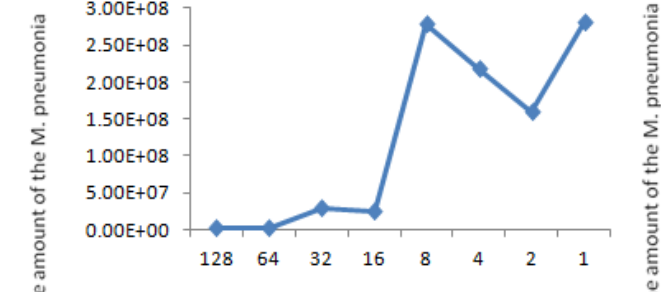
Figure 2. M. pneumoniae was incubated at 37 °C with various concentrations of Baicalin and Qinbai by the serial double dilution method. MIC was 16 μg/mL for Baicalin and 100 μg/mL for Qinbai at which the metabolism of the organisms was inhibited and lack of color change was observed. Resultant mixtures are measured by real-time quantitative PCR. Baicalin and Qinbai demonstrated a reasonably good activity against M. pneumoniae . Our study suggests that Baicalin may have great potential in clinical